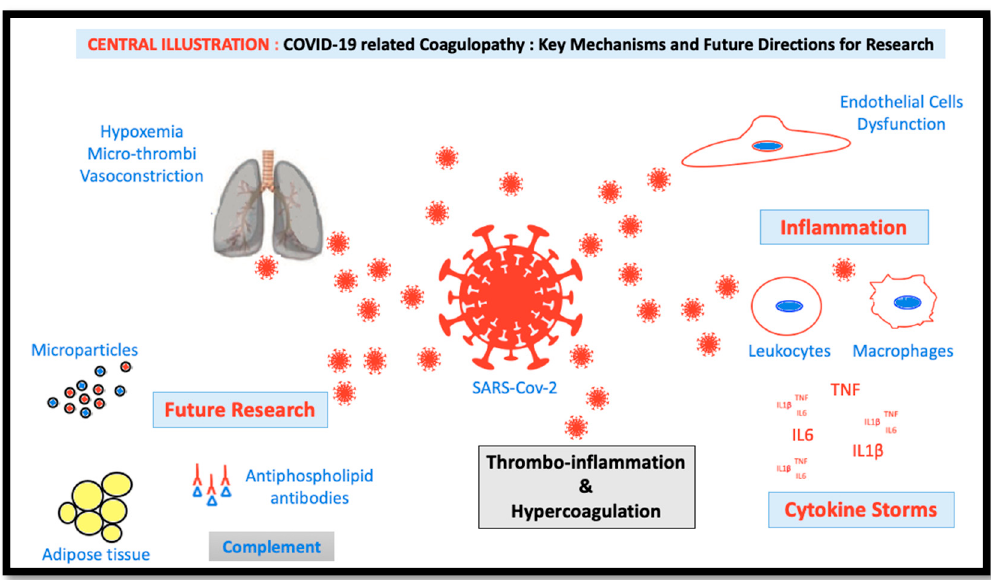
Figure 1. Conceptual figure highlighting major key mechanisms for COVID-19 coagulopathy and future directions in research.